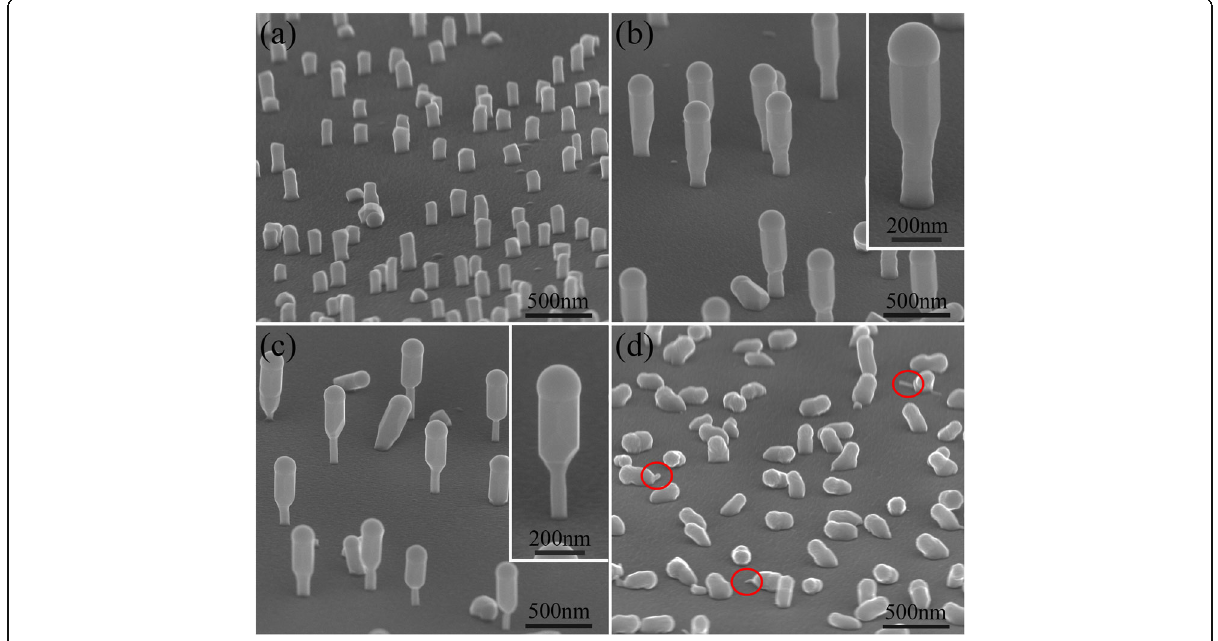
Fig. 2 The 80°-tilted SEM images of the GaSb nanowires grown on InAs stems at a 480 °C, b 500 °C, c 520 °C, and d 545 °C for 20 min. The growth conditions of the InAs nanowire stems were kept constant. Insets in b and c show higher magnification SEM images. The red circles in d mark the residual InAs